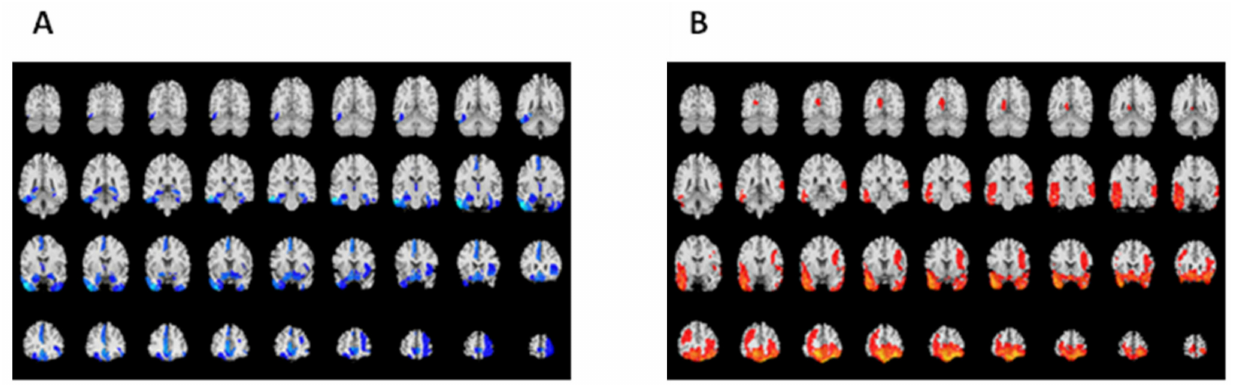
Figure 1. Lesion map following TBI ( A ) and differences in GM volumes between TBI participants and healthy controls ( B